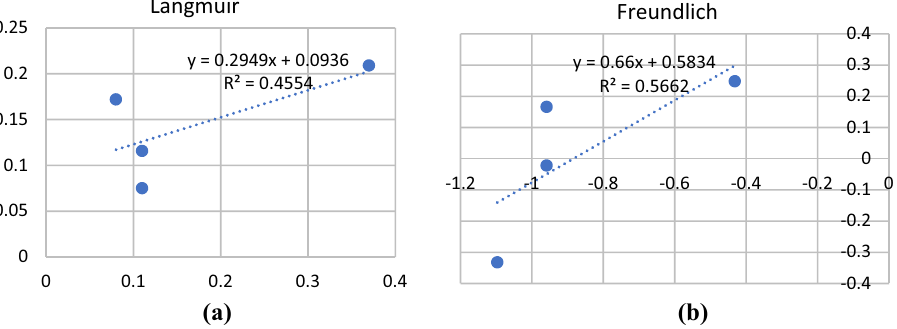
Figure 6. Adsorption curves of Cd 2+ by magnetite as a function of pH ( a ) after 60 min of contact time. This value was relatively unchanged at pH 8 with longer contact times ( b ); adsorption as a function of Cd 2+ concentration at pH 8 and 60 min of contact time ( c ).